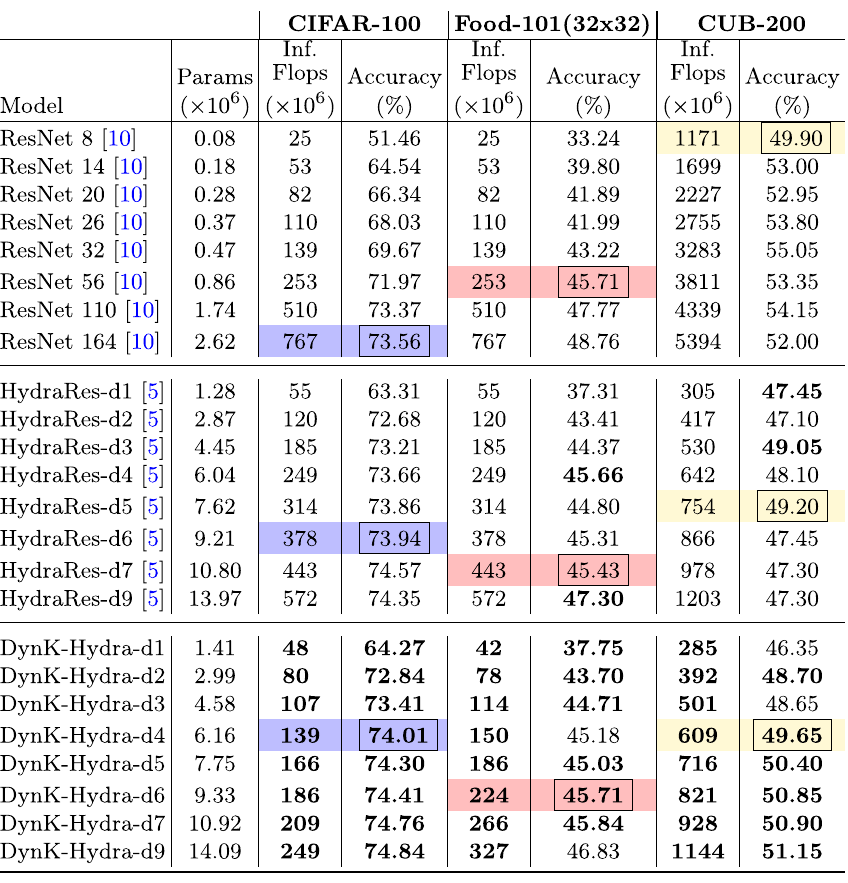
Table 1 Comparison of our DynK-Hydra with HydraRes [5] and ResNet [10] on CIFAR-100, Food-101 (best viewed in